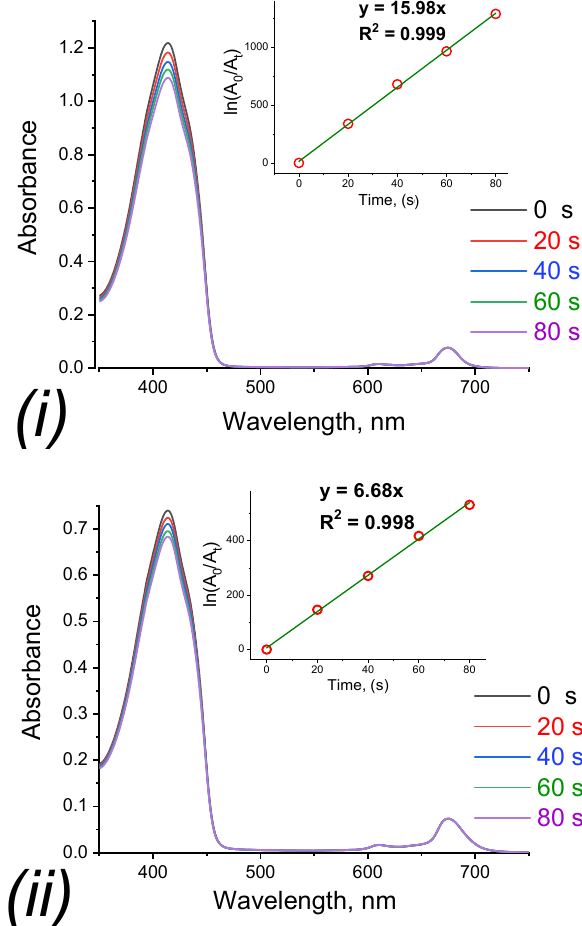
Figure 7. UV-vis absorption spectra changes for 4 ( i ) and 5 ( ii ) in THF upon determination of singlet oxygen quantum yields.